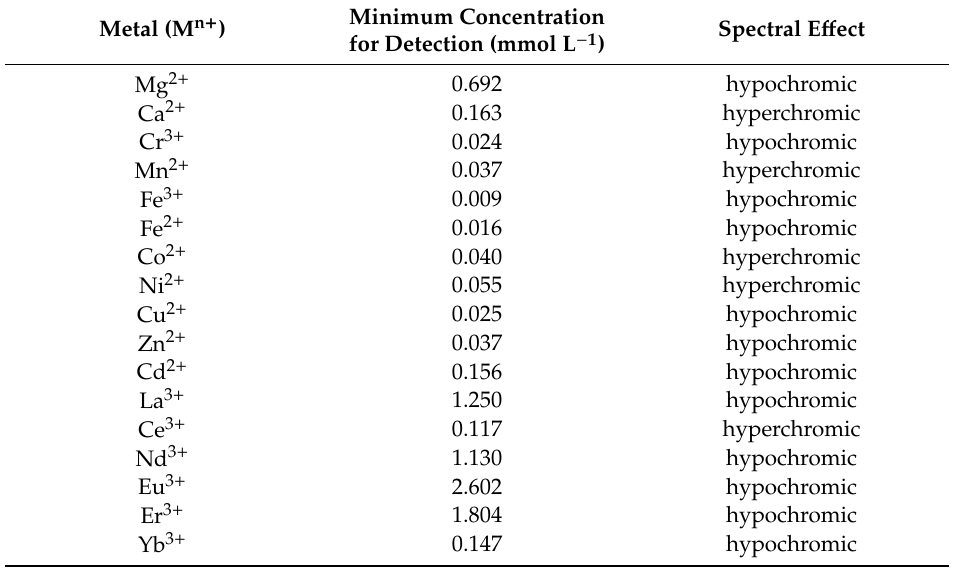
Table 1. Metal ions and their minimum concentration detected by PEGSP2 in solution. Wavelength of maxima absorption ( λ max) chosen was 349 nm.